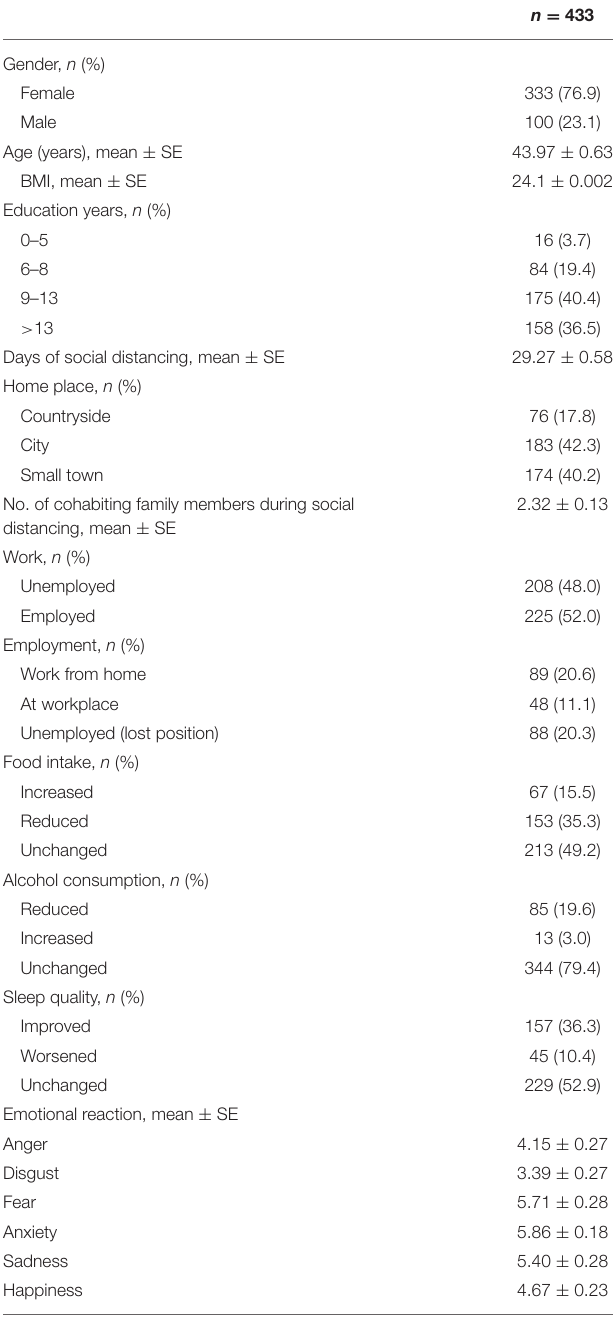
TABLE 1 | Baseline characteristics of the included